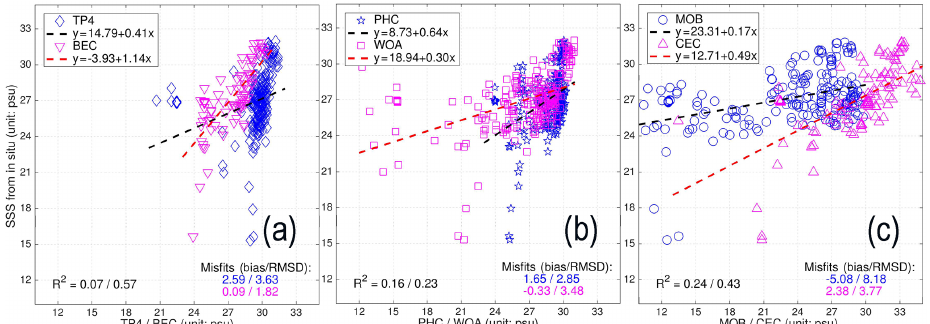
Figure 11. Scatterplots of SSS compared to the in situ observations in the Beaufort Sea during the summer months of 2011–2013. (a) The diamond (inverted triangle) represents the SSS from TP4 (BEC) with blue (purple), and the linear regression is denoted by the dashed black (red) line. (b) The star (square) from the climatology of PHC (WOA). (c) The circle (triangle) represents from MOB (CEC). The coefficient R 2 is the squared linear relationship between the evaluated product and the in situ SSS, and the misfits are also shown on the